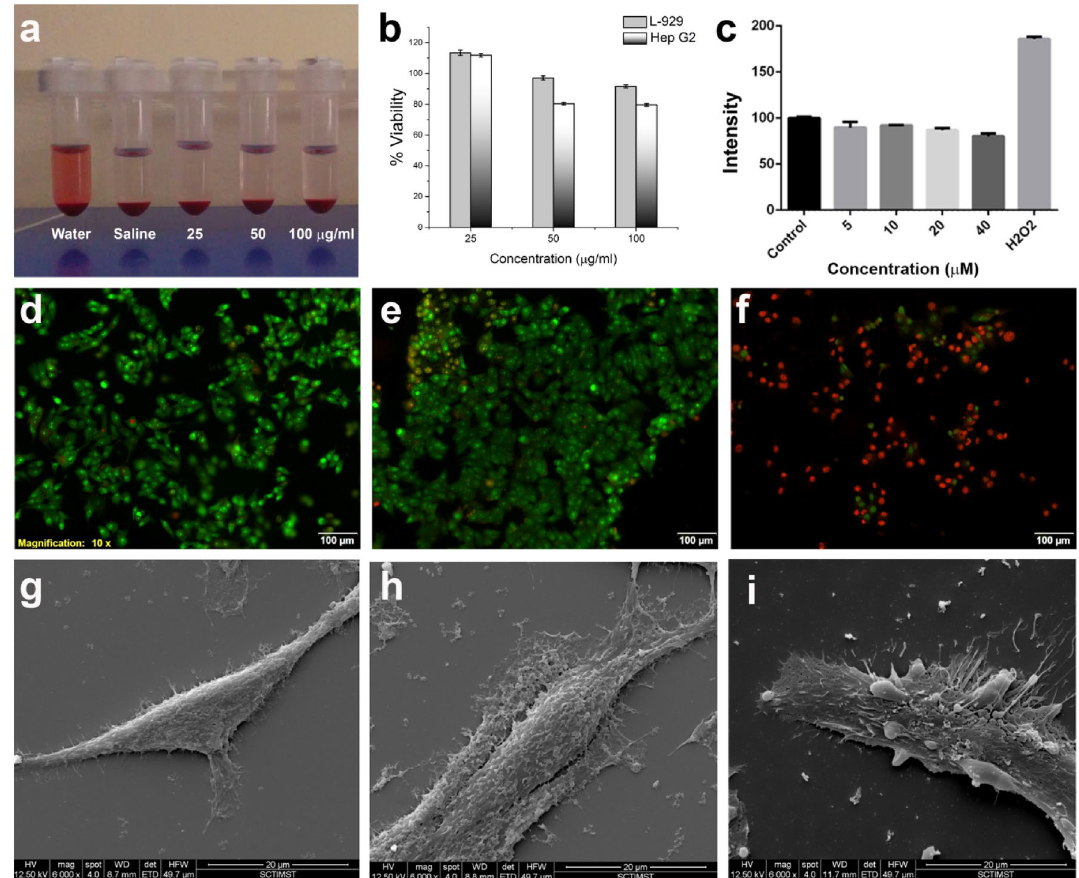
Figure 3. In vitro evaluation of P-SPIONs. ( a ) Hemocompatibility assay and ( b ) cell viability assay of P-SPIONs. ( c ) Represent the quantification of ROS generated from P-SPIONs through DCFDA assay. ( d – f ) Live/dead assay and ( g – i ) ESEM images of HepG2 cells subjected to hyperthermia treatment of units/l) indicate the development of liver fibrosis. MRI of the anesthetized animals was performed after 15 min of tail vein injection of P-SPIONs. Post contrast T 2 weighted images of liver showed significant hypo-intensity with a reduction in the signal intensity (SI) (Fig. 4a–e). The signal reduction indicates cumulative iron uptake by Kupffer’s cells. The average SI value decreases from 157 ± 19 (pre-contrast images) to 51 ± 11 (post contrast images) with 67% variation providing a remarkable negative contrast effect (Fig. 4c). On detailed inspection of the MR image, the presence of few streaky linear hyper intense areas is visualized in the hypo intense liver, indicating the fibrotic regions in the affected liver. The pre to post contrast signal intensity ratio of P-SPIONs is very high (67%) compared to the 39% and 55% of C-USPIONs and D-SPIONs reported earlier (Fig. S7). The difference in pre to post contrast signal intensity ratio is statistically significant ( p < 0.05) between all the three groups considered. This difference can be attributed to the effect of ASGPR mediated endocytosis in liver due to the presence of pullulan 15,16 . ASGPR is present in large numbers on the sinusoidal cell membrane of hepatocytes and mediates the endocytosis of desialylated glycoproteins containing terminal galactose or N-acetylgalactosamine 40 . ASGPR-mediated liver targeted delivery of Dox-loaded galactosamine-